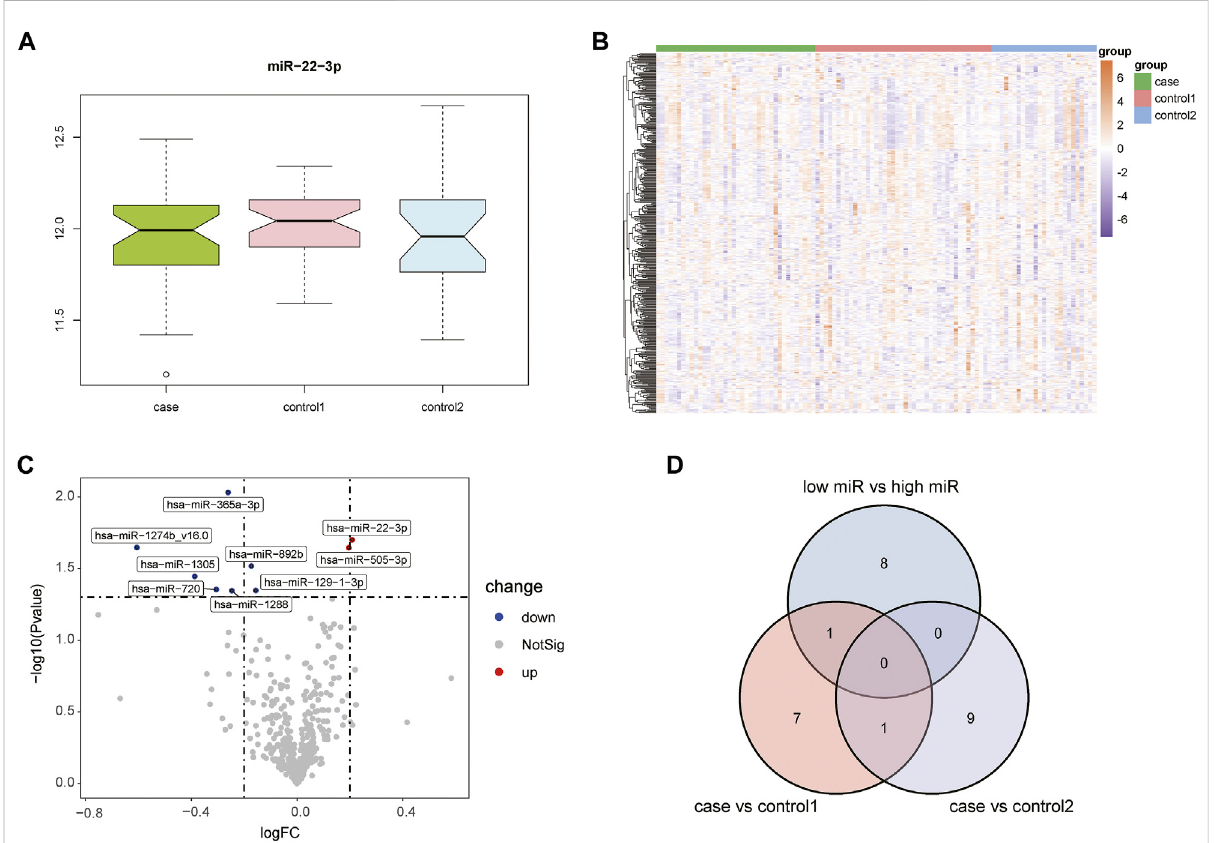
FIGURE 1 Acquisition of DEGs from the GSE105449 dataset. (A) Boxplot showing miR-22-3p expression. (B) Heatmap showing the mRNA expression pro fi les of case samples, control 1 and control 2. (C) Volcano map of DEGs. Red, green, and gray represent upregulated differential genes, downregulated differential genes, and no differential genes, respectively. (D) Venn diagram of overlapping DEGs from the intersection of two independent